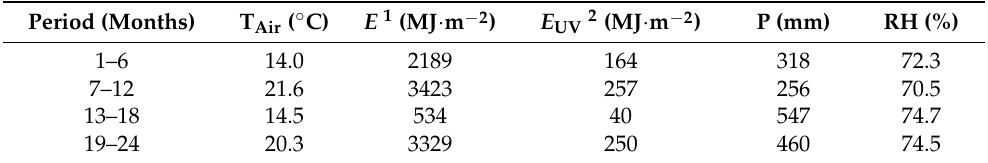
Table 1. Climate parameters of the exposure site. (Notation: T Air —average air temperature; E — accumulated solar radiant energy; E UV —accumulated UV radiant energy; P—accumulated precipita- tion; RH—average relative humidity). Period